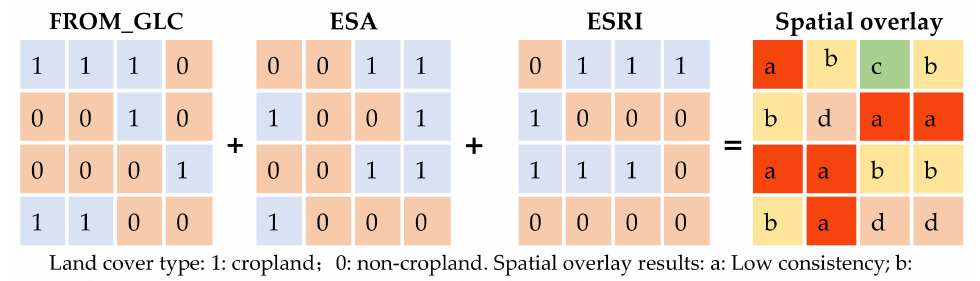
Figure 3. Spatial overlay map of different products (cropland as an